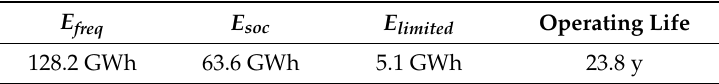
Table 2. FR-ESS objective function calculation results.